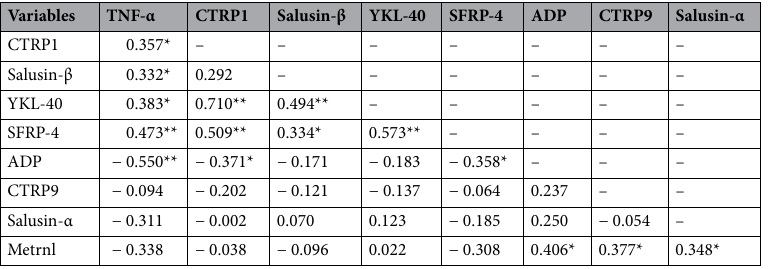
Table 4. The correlation matrix of serum inflammatory cytoadipokines. CTRP, complement-Clq TNF-related protein; YKL-40, Chitinase-3-like protein 1; SFRP4, secreted frizzled-related protein 4; ADP, adiponectin; Metrnl, Meteorin-like. *P < 0.05, **P <